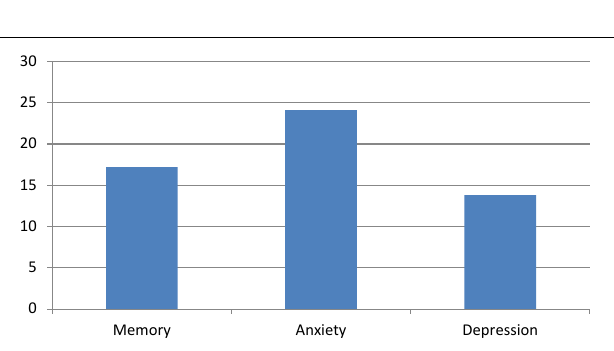
FIGURE 3 | Percentage in worsening in COVID + group referred by the caregiver.